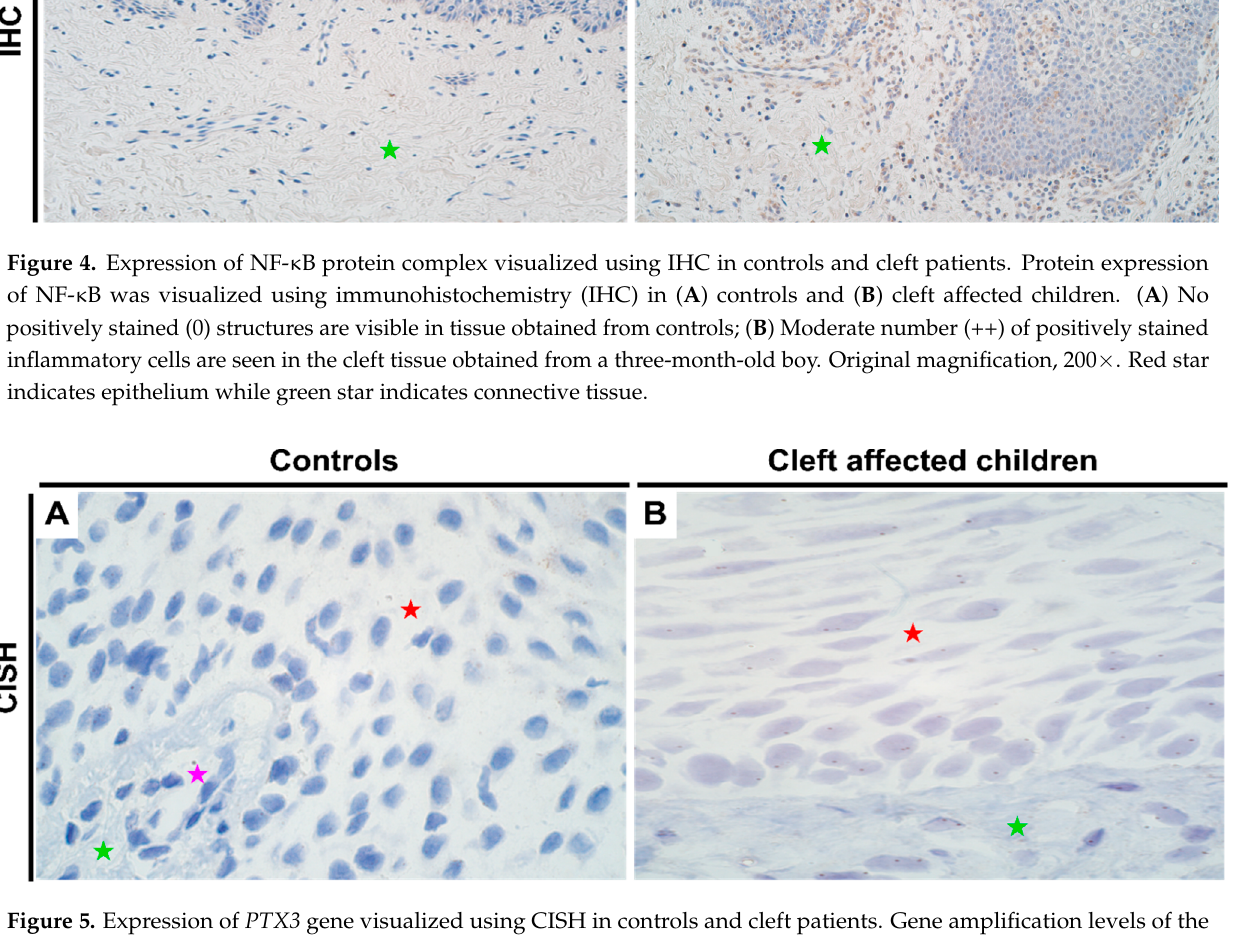
Figure 5. Expression of PTX3 gene visualized using CISH in controls and cleft patients. Gene amplification levels of the PTX3 gene was visualized using chromogenic in-situ hybridization (CISH) in ( A ) controls and ( B ) cleft affected children. ( A ) No gene amplification (0) is seen in the tissue obtained from controls; ( B ) No gene amplification (0) is seen; however, gene expression is seen by brown dots in the nucleus of the epitheliocytes and connective tissue cells in the cleft tissue obtained from a five-month-old girl. Original magnification, 1000×. Red star indicates epithelium; green star indicates connective tissue, while purple star indicates endothelial cells.